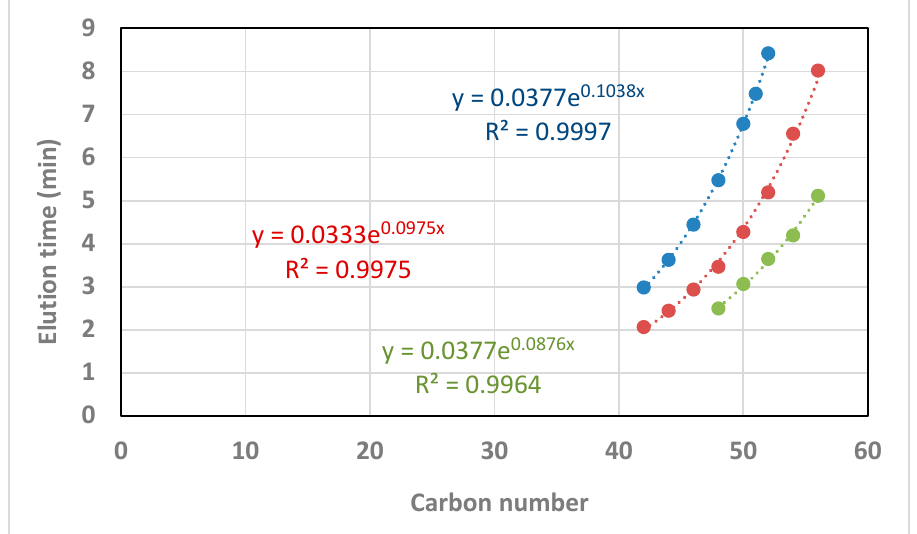
Figure 11. Correlations of elution time (min) against the carbon number for TAGs with 0 double bonds (blue), 2 double bonds (red), and 4 double bonds (green) for 9.13 mM [NH 4 OH].